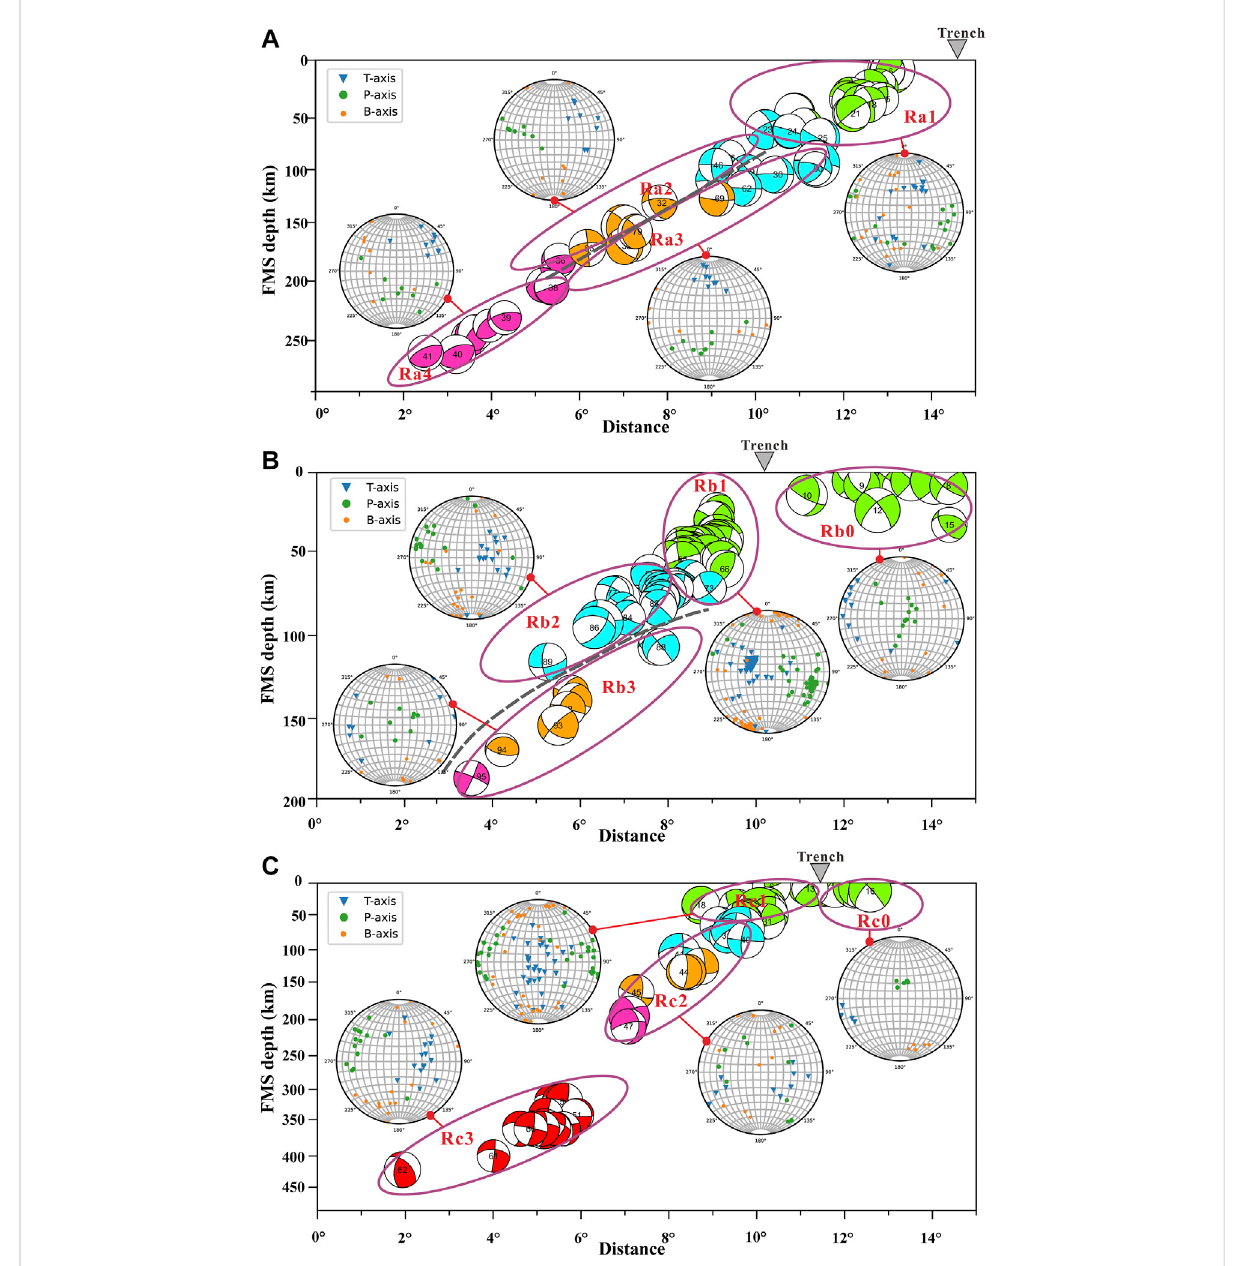
The outlining ofWBZ subvolumes of homogeneousstress fi eld, based on adetailed analysis of theorientation spatial distributionof theP and T axesinPro fi leA-A ’ (A) andB-B ’ (B) andC-C ’ (C) ,respectively.StereographicprojectionoftheP(greendots)andT(blueinvertedtriangles)andBaxes (yellowpolygons)ofthefocalmechanismsareplottednexttothesubvolumesandlinkedbyaredsolidline.Stereographicprojectiondiagrams were producedusing an open-sourcepythonpackagenamed mplstereonet(version 0.6.2).The graydashed linesin (A,B) show theinterface ofWBZ upper and lower plane. The number in the center of focal mechanisms corresponds to the events number in Supplementary Table